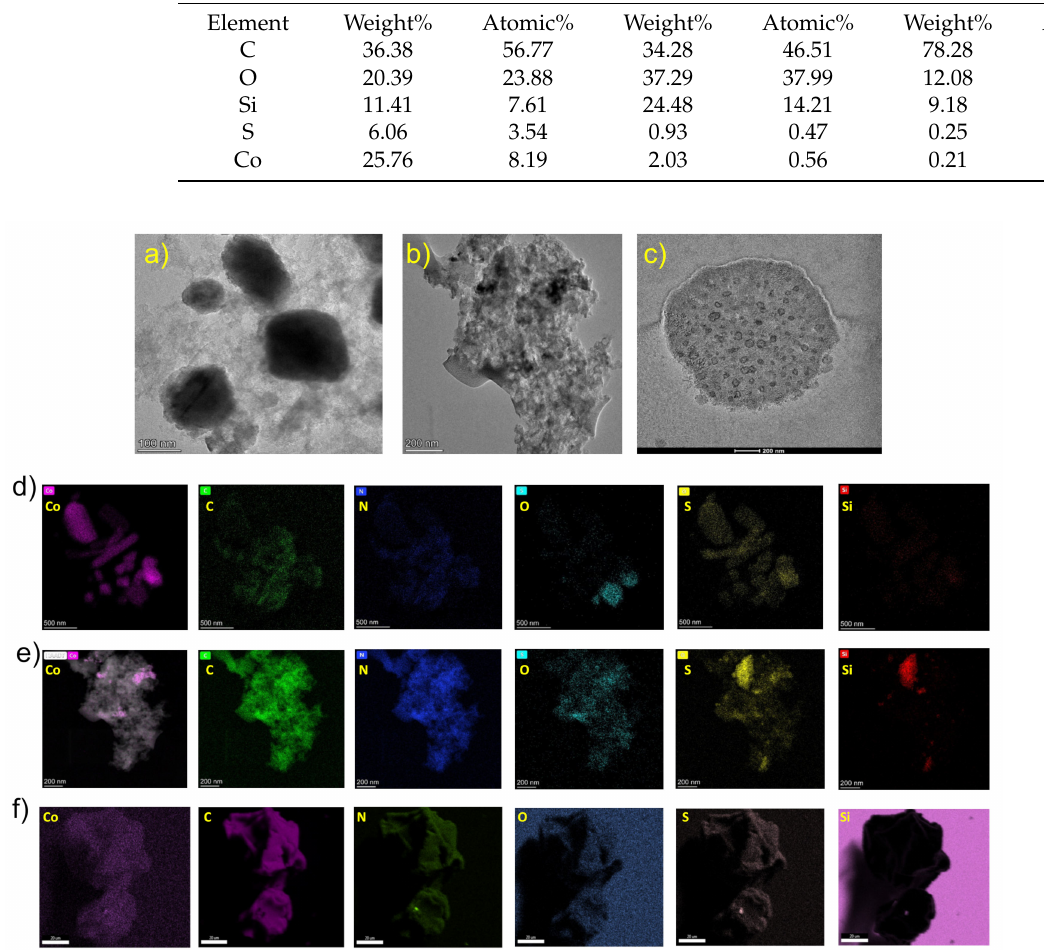
Figure 2. TEM images, and EDS-HAADF mapping of nanocomposites (1), (2) and (3); TEM analysis of (1) ( a ), (2) ( b ), and (3) ( c ); EDS-HAADF mapping of (1) ( d ); EDS-HAADF mapping of (2) ( e ); EDS-HAADF mapping of (3) ( f